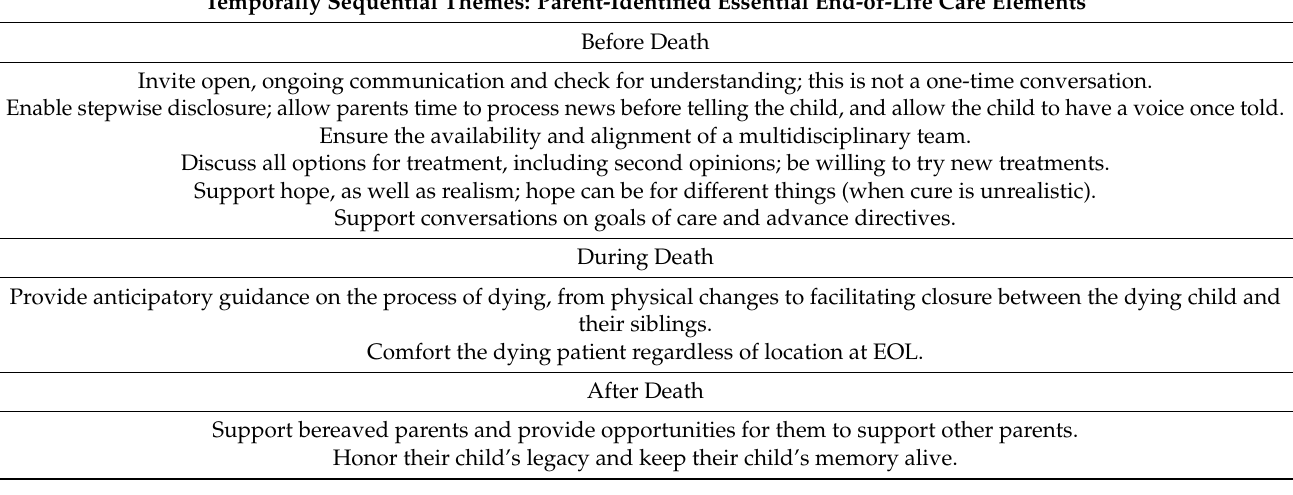
Table 2. Temporally sequential themes: parent-identified essential end-of-life care